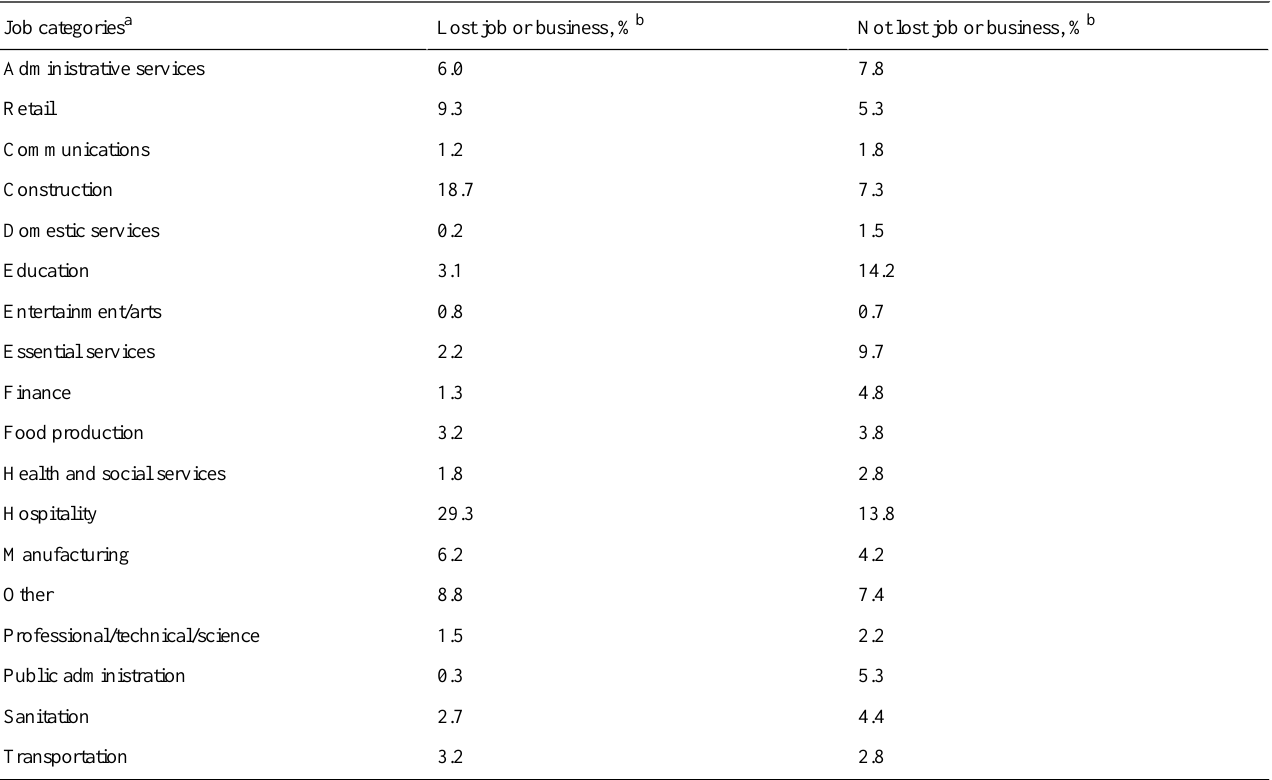
Table 2. Distribution of jobs between respondents who had or were in danger of losing their job/business vs those who were not (Cramér’s